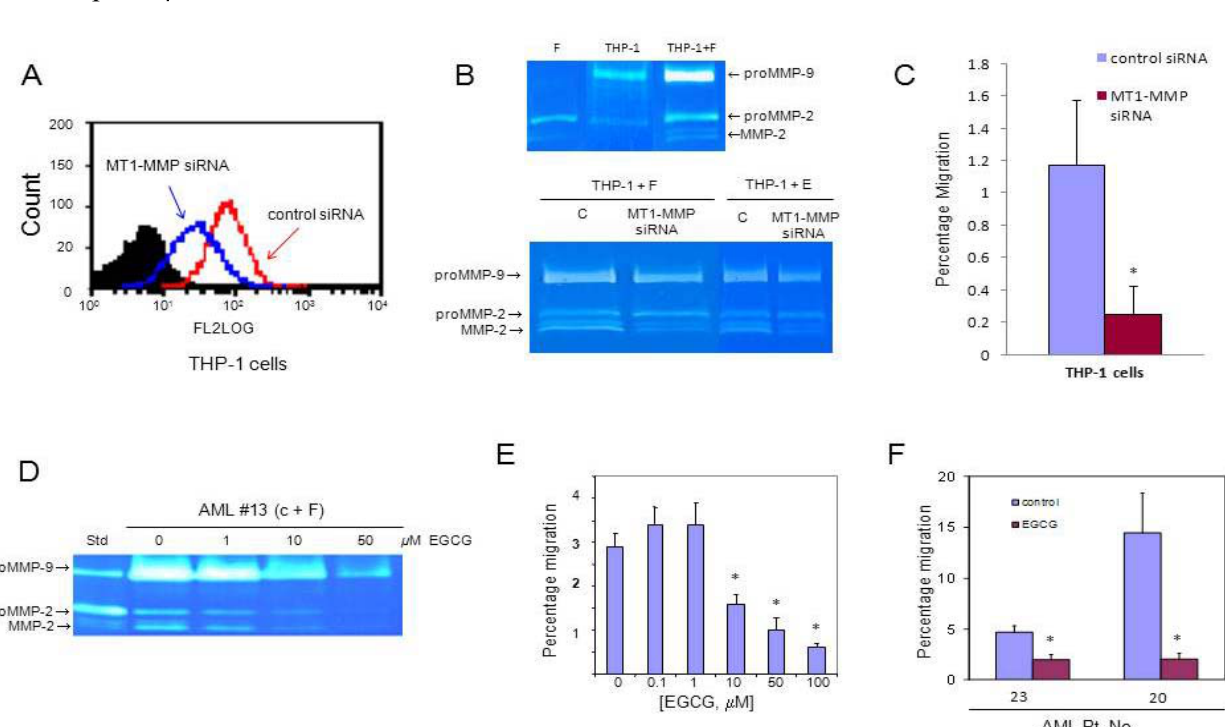
Figure 2. Inhibition of MT1-MMP expression and its effect on trans-Matrigel migration.